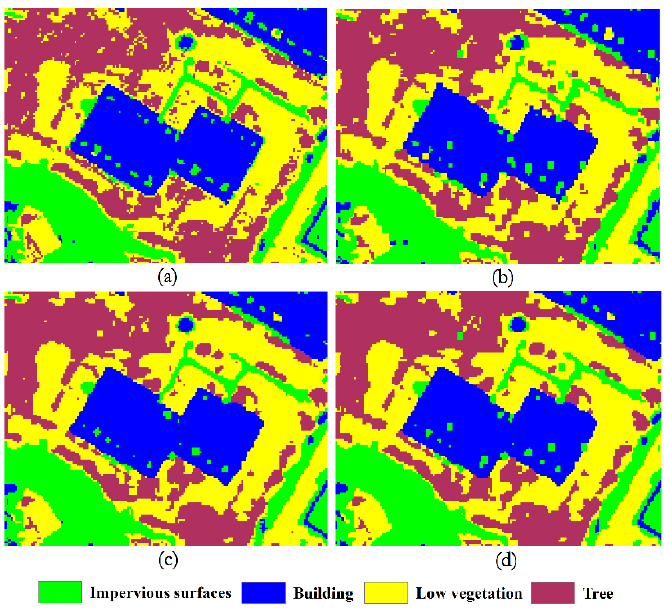
Figure 9. Classification maps of Vaihingen image: ( a ) OCM, ( b ) RCM_SU, ( c ) RCM_SDU, and ( d )